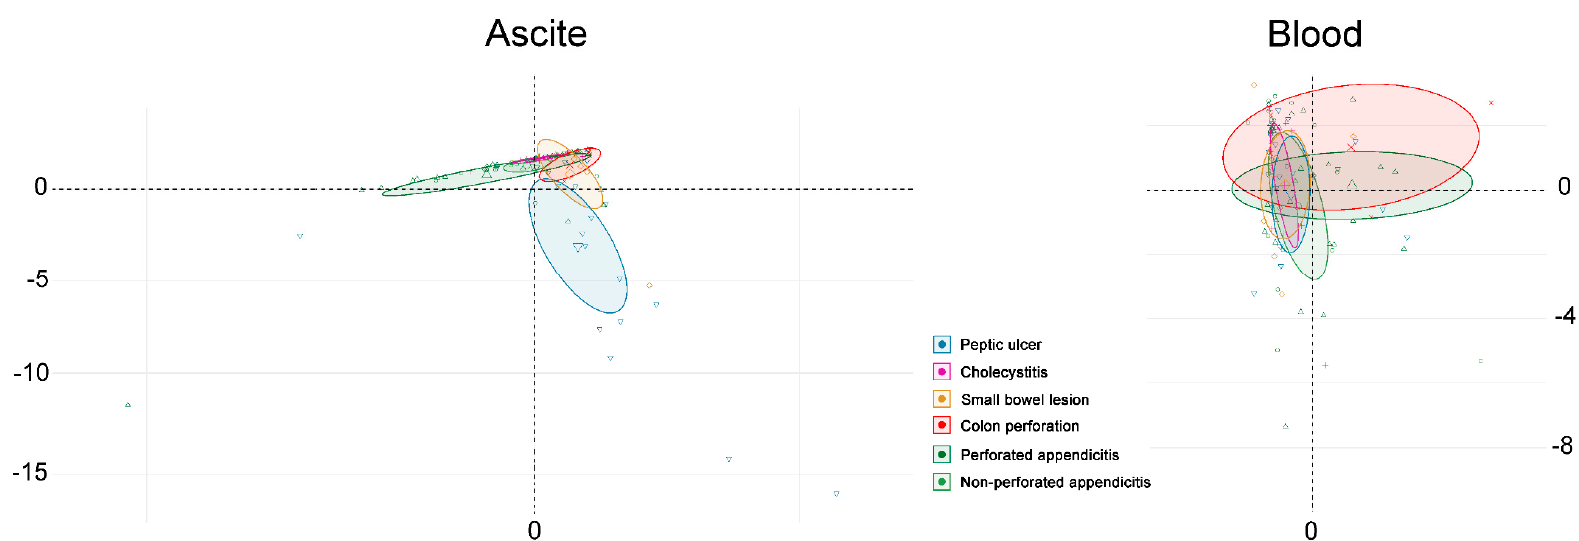
Figure 2. A principal component analysis conducted on the bacteria of ascites and blood to separate patients with different etiologies of acute surgical abdomen (PC1 explaining 34.1% of the variance; PC2 explaining 22.6% of the variance).